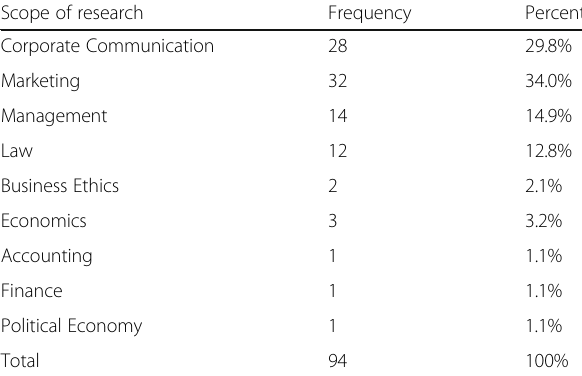
Table 2 Analysis of the scope of